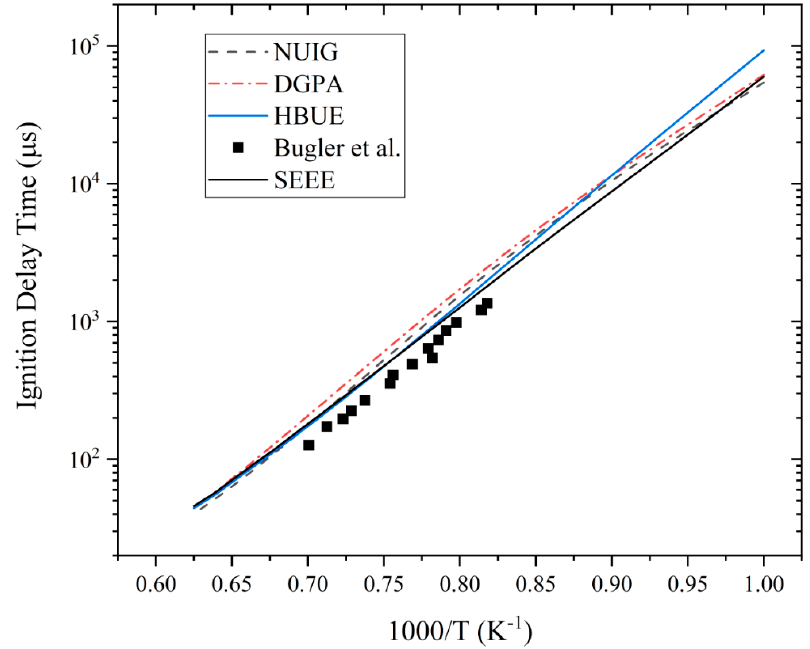
Figure 6. Comparison of the ignition delay times between NUIG, DGPA, HBUE, SEEE, and experimental data at an equivalence ratio of 1.0.